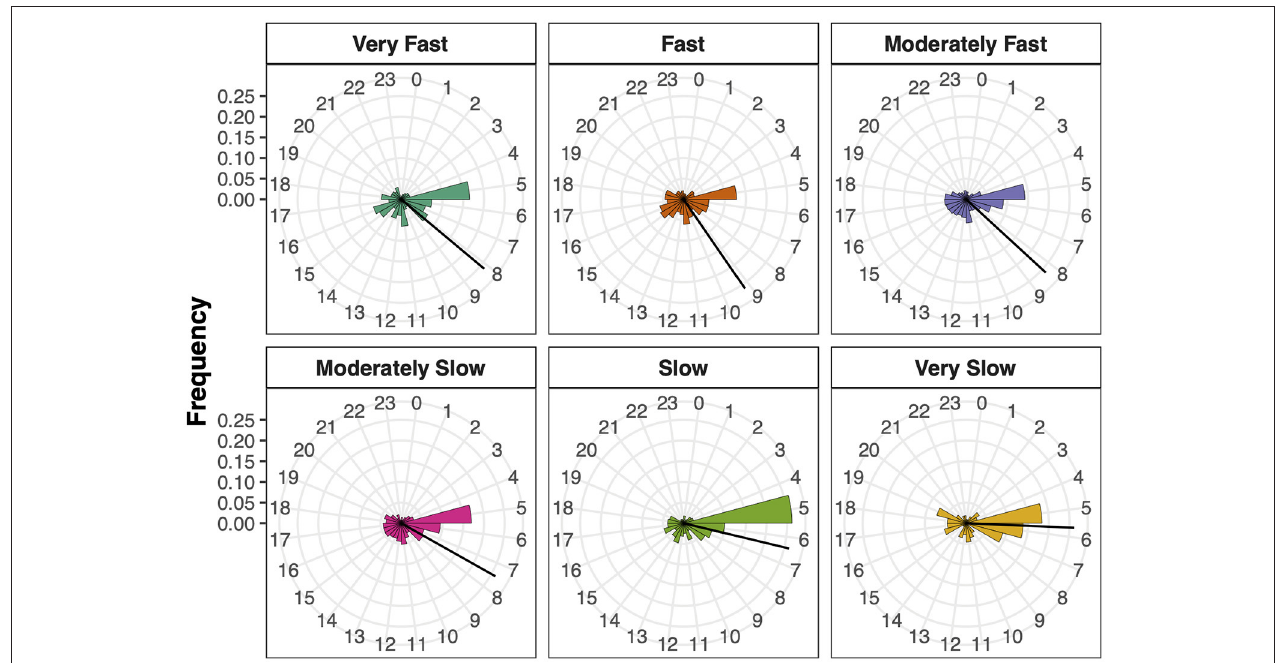
FIGURE 3 | Time of the day per SMT cluster. Bars show the hour of test execution and the bar length shows the frequency per hour. The black lines represent the circular mean per SMT cluster.